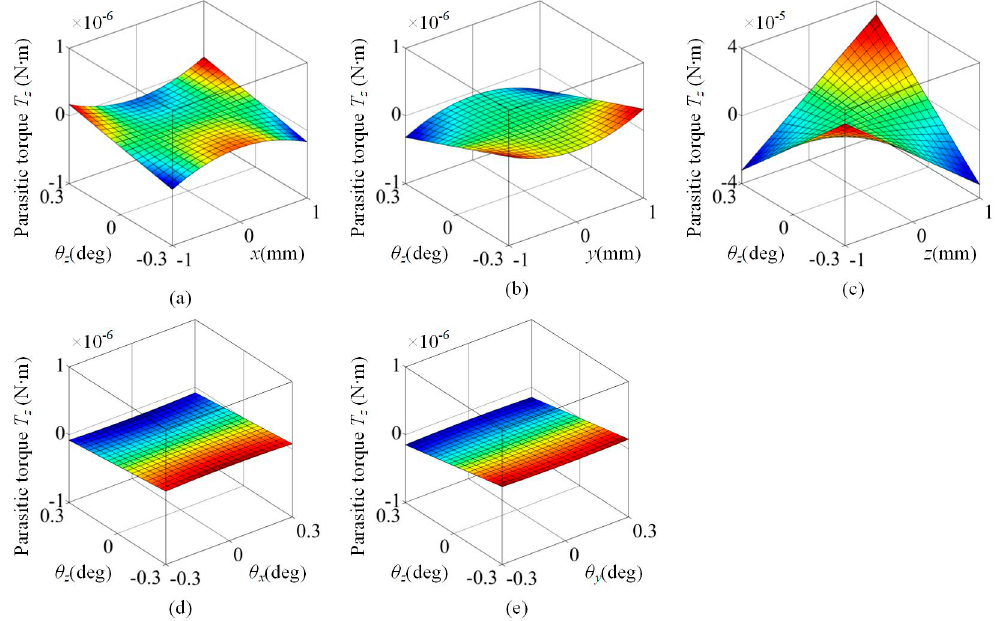
Figure 9. Parasitic torque T z characteristic of the HMF-VCA varied with the mover’s motion. ( a ) T z vs. θ z and x . ( b ) T z vs. θ z and y . ( c ) T z vs. θ z and z . ( d ) T z vs. θ z and θ x . ( e ) T z vs. θ z and θ y .